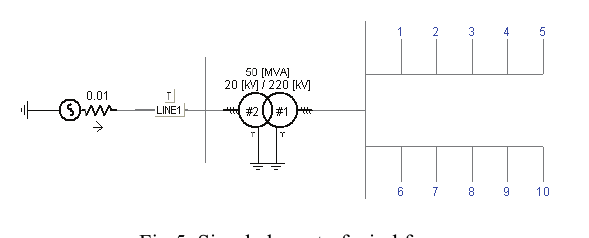
Fig.5. Simple layout of wind farm Table 1. The parameters of one DFIG